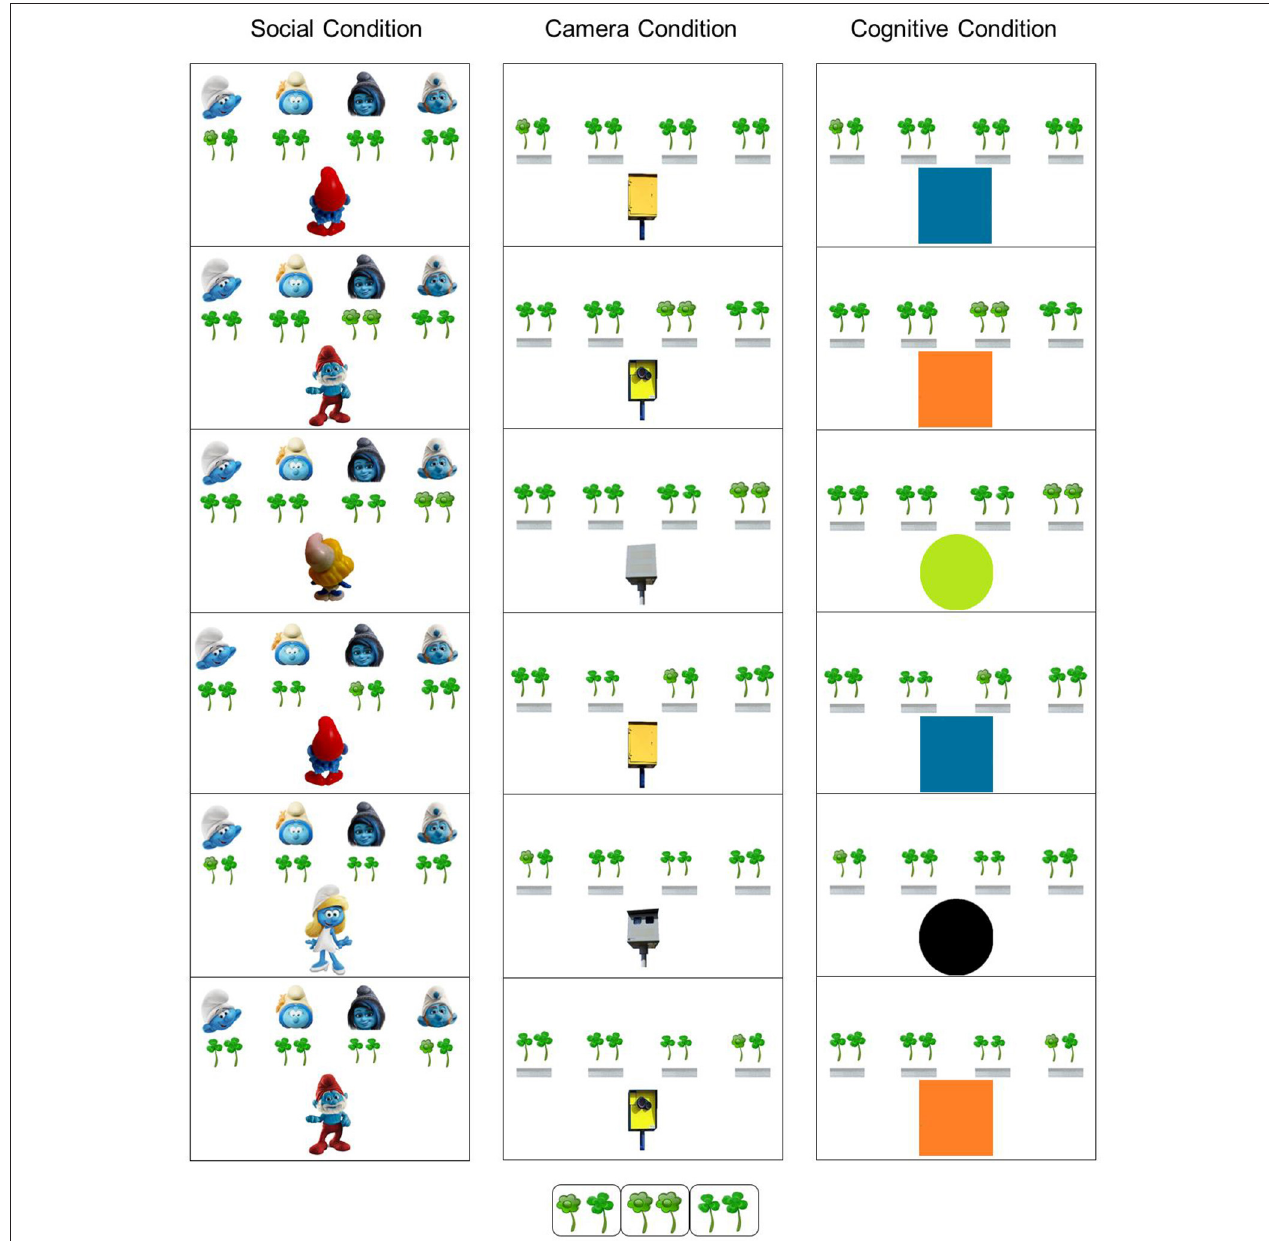
FIGURE 4 | Schematic example of the belief SRT task in Experiment 2, showing the first six trials of the embedded sequence. On each trial, participants had to report the amount of green flowers (pressing “1” or “2” on the keyboard), as seen by the smurf ( Social Condition ), on the photos ( Camera Condition ), or depending on a shape’s color ( Cognitive Condition ). In all conditions, the amount of flowers was determined by the orientation of the smurf or camera (toward vs. away from the flowers) or the color of the shape (green/blue vs. orange/black). Unknown to the participants, there was a fixed 16-trial sequence of the Protagonist (smurf/camera/shape), Orientation (belief orientation/camera orientation/color of shapes) and flowers’ Location (for the full sequence, see Table 1 and Supplementary Presentation 2 ). The amount of flowers was completely random, hence making the response unpredictable from trial to trial, and dissociating sequence learning from motor responses. [Inset Bottom ] The inset shows a display in which one flower is surrounded by one clover (as a distraction; of approximately the same shape and color), a display with two flowers, and a display with two clovers.